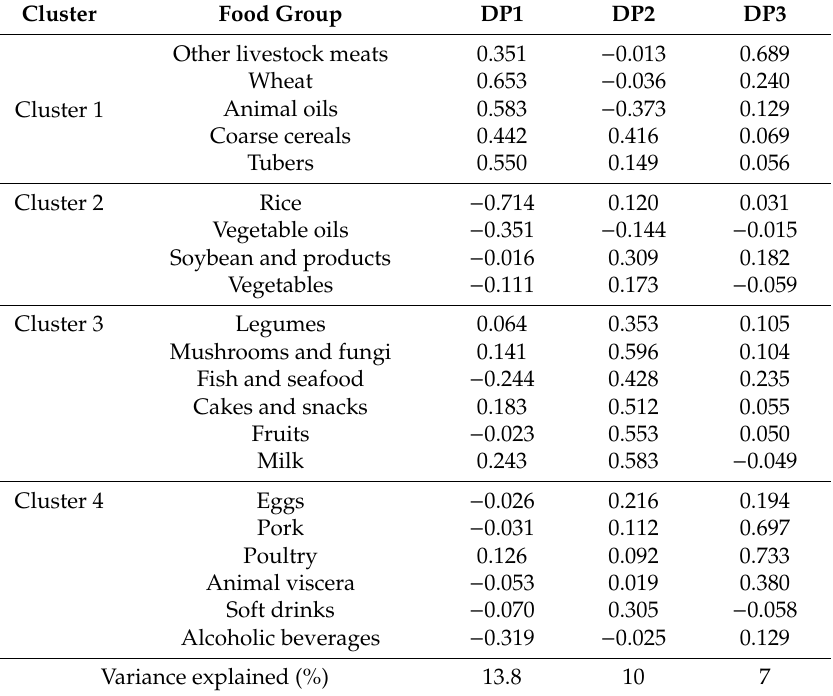
Table 2. Food group factor loadings for di ff erent dietary patterns